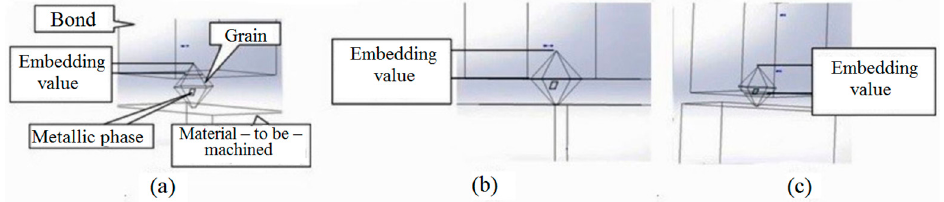
Figure 2. Model for the analysis of the influence of grain embedding value on DM in grinding area for ( a ) h emb = 20%, ( b ) h emb = 50%, and ( c ) h emb =